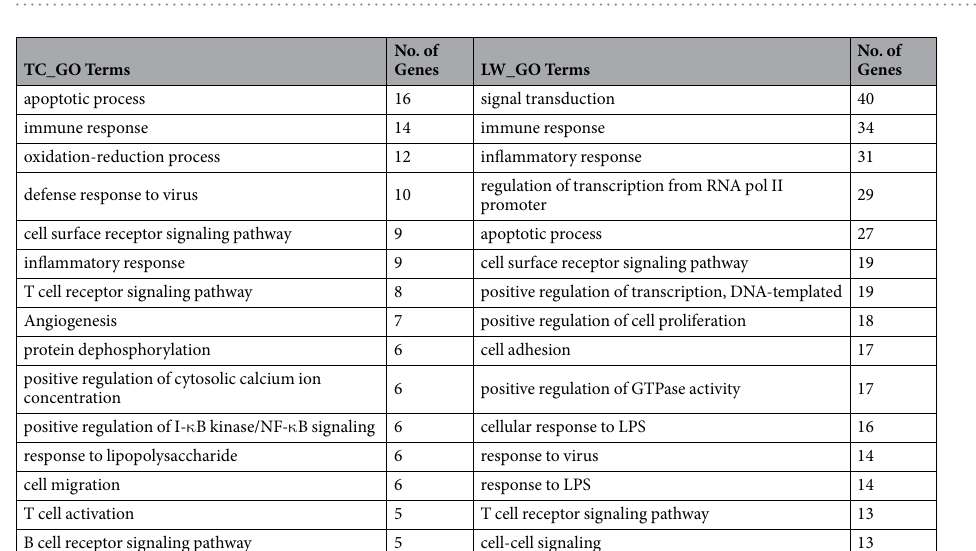
Figure 6. ( a ) Log2 (FC) obtained from qRT-PCR and RNA-seq data. X-axis is the name of selected DElincRNA and Y-axis is the value of log2 (FC); ( b ) Tissue/cell expression analysis of five lincRNAs. MLN represents for mesenteric lymph nodes and ILN represents for inguinal lymph nodes.